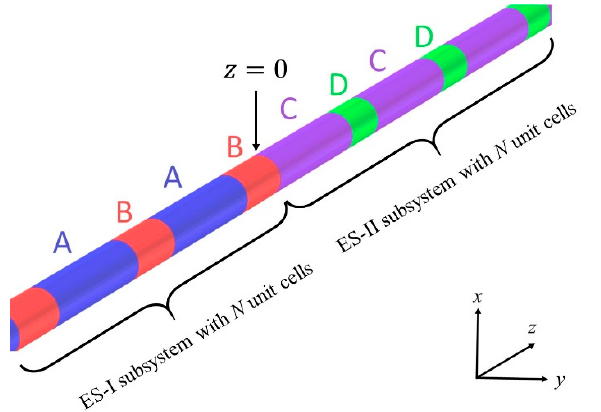
Figure 1. A one-dimensional elastic string system composed of ES-I and ES-II subsystems at the interface ( z = 0).